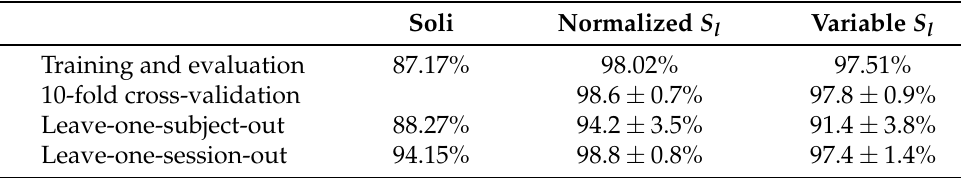
Table 2. Accuracy result comparison with Soli. Results for 50–50% split for training and evaluation, 10-fold cross-validation, leave one subject and session out, using an SVM classifier. For an LSM with 460 neurons and C inp =